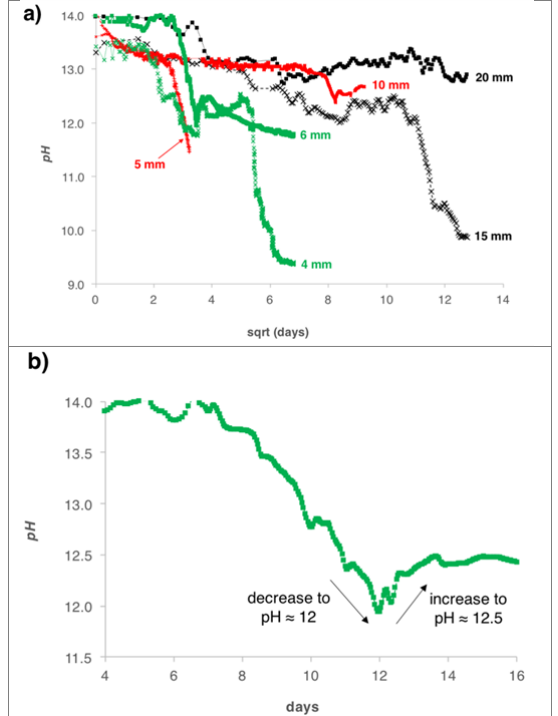
Figure 4. Example of calculated diffusion potential as a function of pH for the IrO x sensor embedded at 15 mm cover depth. The diffusion potential increases as the pH gradient (between IrO sensor and embedded reference electrode x Ag/AgCl ISE) increases, reaching potentials up to ca. 100 mV